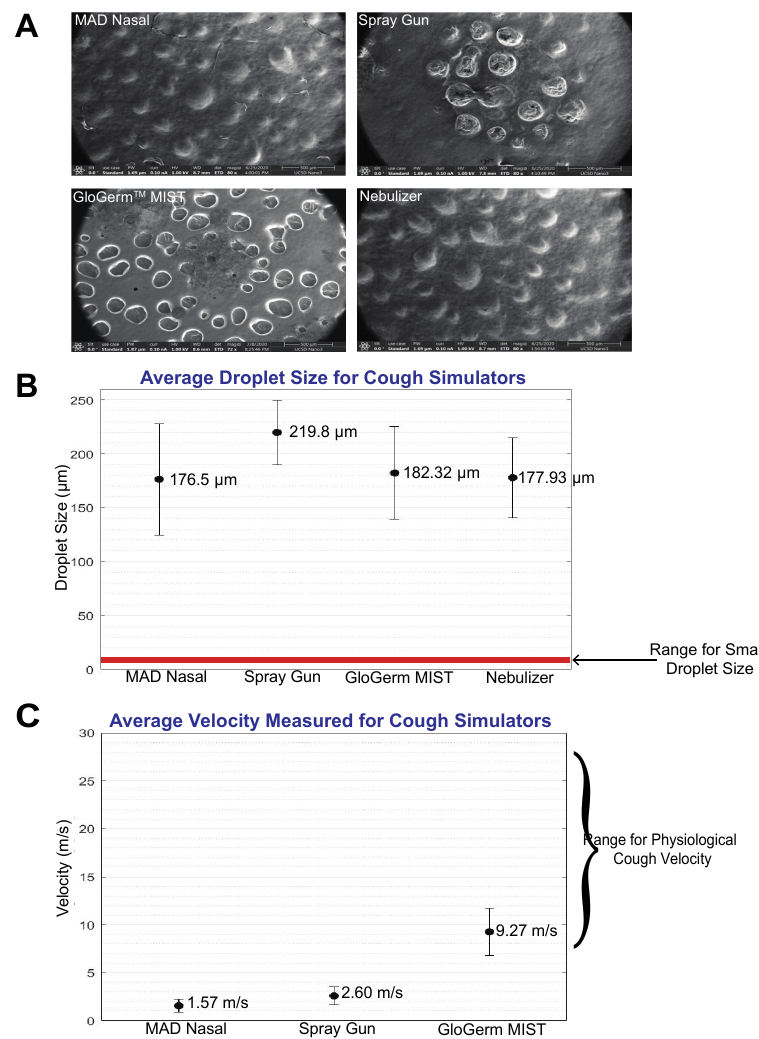
Figure 2. Droplet size and velocity measurements. ( A ) SEM images of droplets produced from simulated coughs produced by MAD Nasal, a spray gun, GloGerm TM MIST, and a nebulizer. ( B ) A categorical plot showing the droplet sizes (µm) produced by each cough simulator. The thickness of the red line indicates the range for small respiratory droplets (5–10 µm), and error bars indicate one standard deviation. ( C ) Categorical plot showing the average measured velocity (m/s) of each cough simulator. Error bars indicate one standard deviation and brackets on the side indicate physiological coughing and breathing velocity ranges.